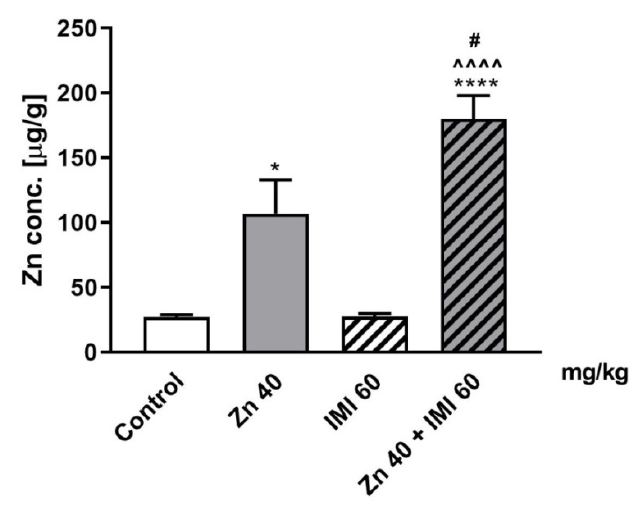
Figure 6. Effect of Zn (40 mg Zn/kg) + IMI (60 mg/kg), and NaCl (control) administered p.o. on Zn concentration in the mouse small intestine. Results are expressed as mean ± S.E.M (n = 4 per group). * p < 0.05; **** p < 0.0001 vs. control group, ^^^^ p < 0.0001 vs. IMI treated group, # p < 0.05 vs. Zn treated group (two-way ANOVA followed by Tukey post-hoc